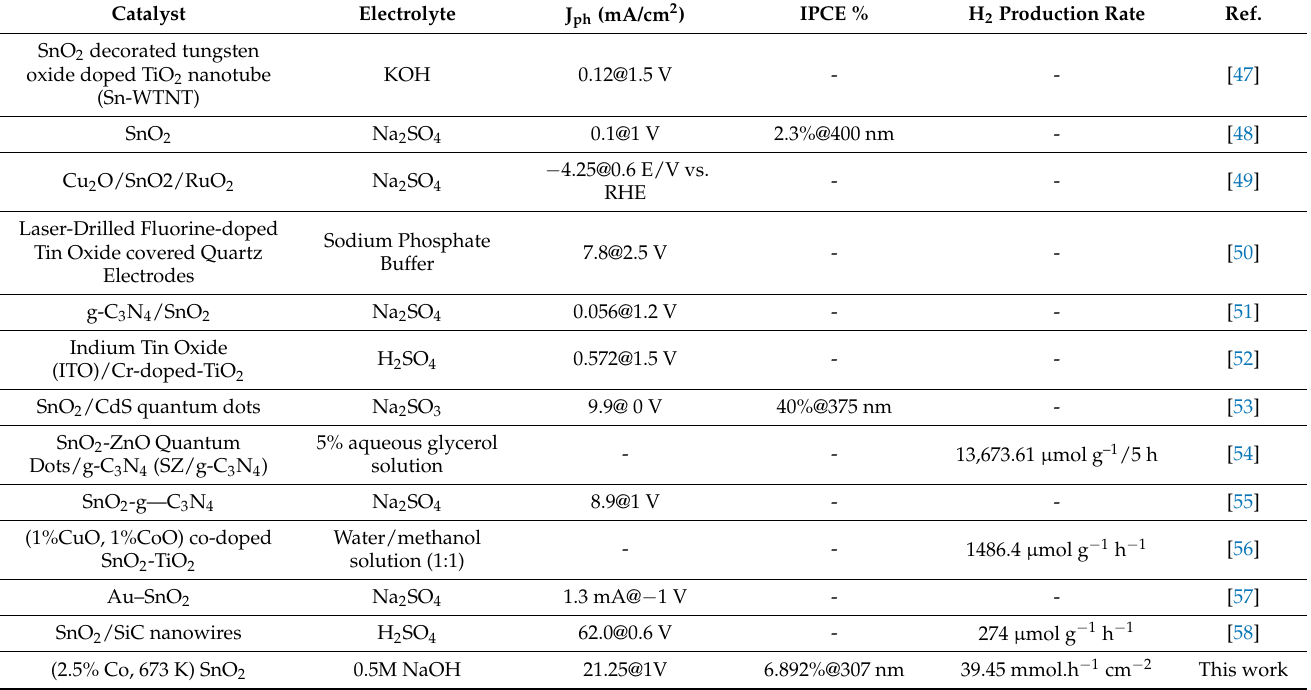
Table 3. Comparison of the values of J ph , IPCE%, and ABPE% for the current work with previously studied values for different SnO 2 ‐ based photocatalysts.